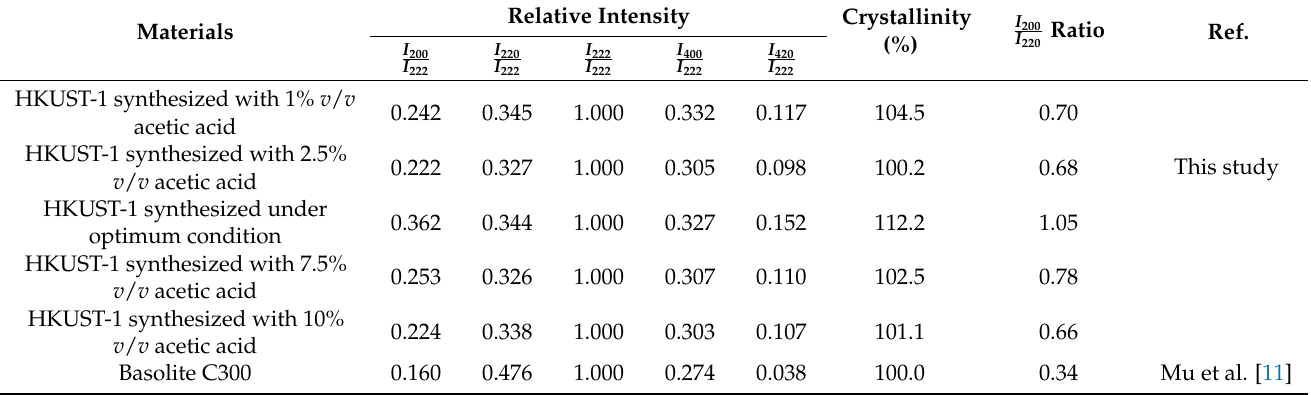
Table 4. Crystal information of HKUST-1 synthesized under optimum condition and with various acetic acid concentrations.